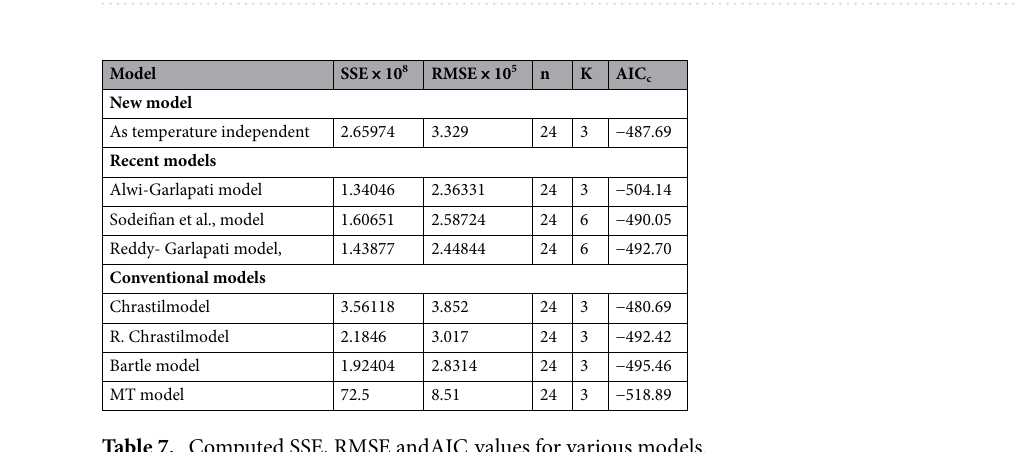
Table 7. Computed SSE, RMSE andAIC c values for various